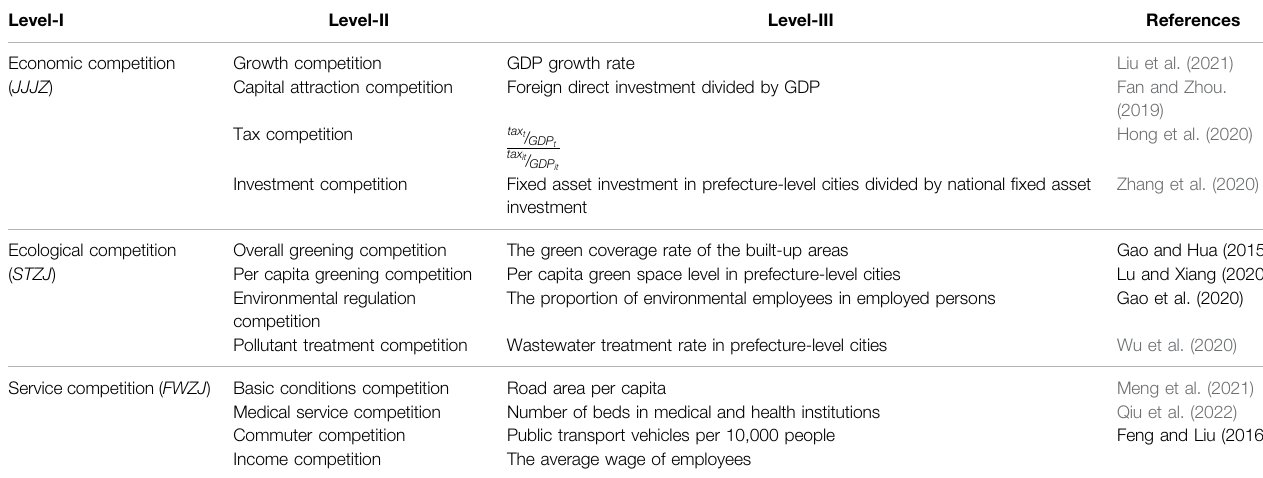
TABLE 2 | Local government competition index